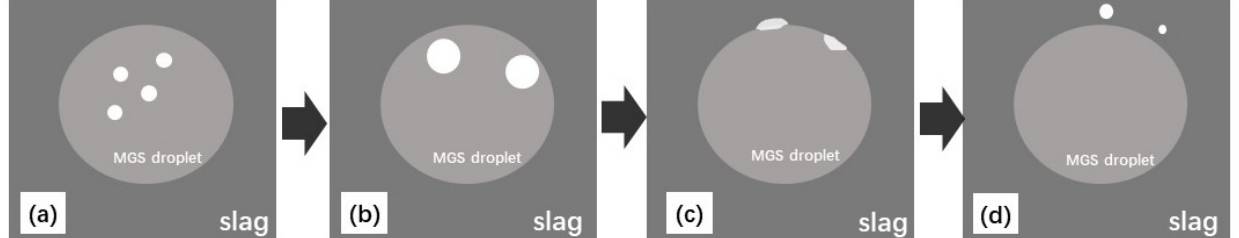
Figure 7. Schematic diagram of the Fe-concentrated phase of MGS transferred to slag; ( a ) Fe-concentrated phase formed within silicon droplets; ( b ) Fe-concentrated phase transferred to silicon-slag interface; ( c ) Fe-concentrated phase wetted with slag and dissolved; ( d ) undissolved Fe-concentrated phase transferred into slag.